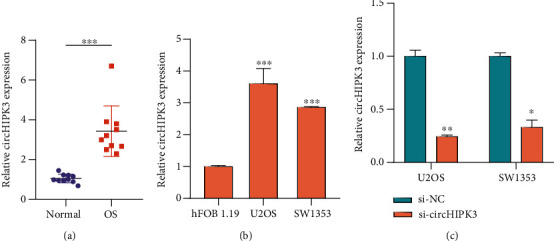
circHIPK3 was upregulated in OS. (a) The expression of circHIPK3 in 10 paired OS tissues was measured by qRT-PCR. (b) Relative expression of circHIPK3 in OS cell lines (U2OS, SW1353) and human osteoblasts (hFOB 1.19). (c) circHIPK3 expression in OS cells transfected with si-circHIPK3 or si-NC. ∗p < 0.05, ∗∗p < 0.01, and ∗∗∗p < 0.001.